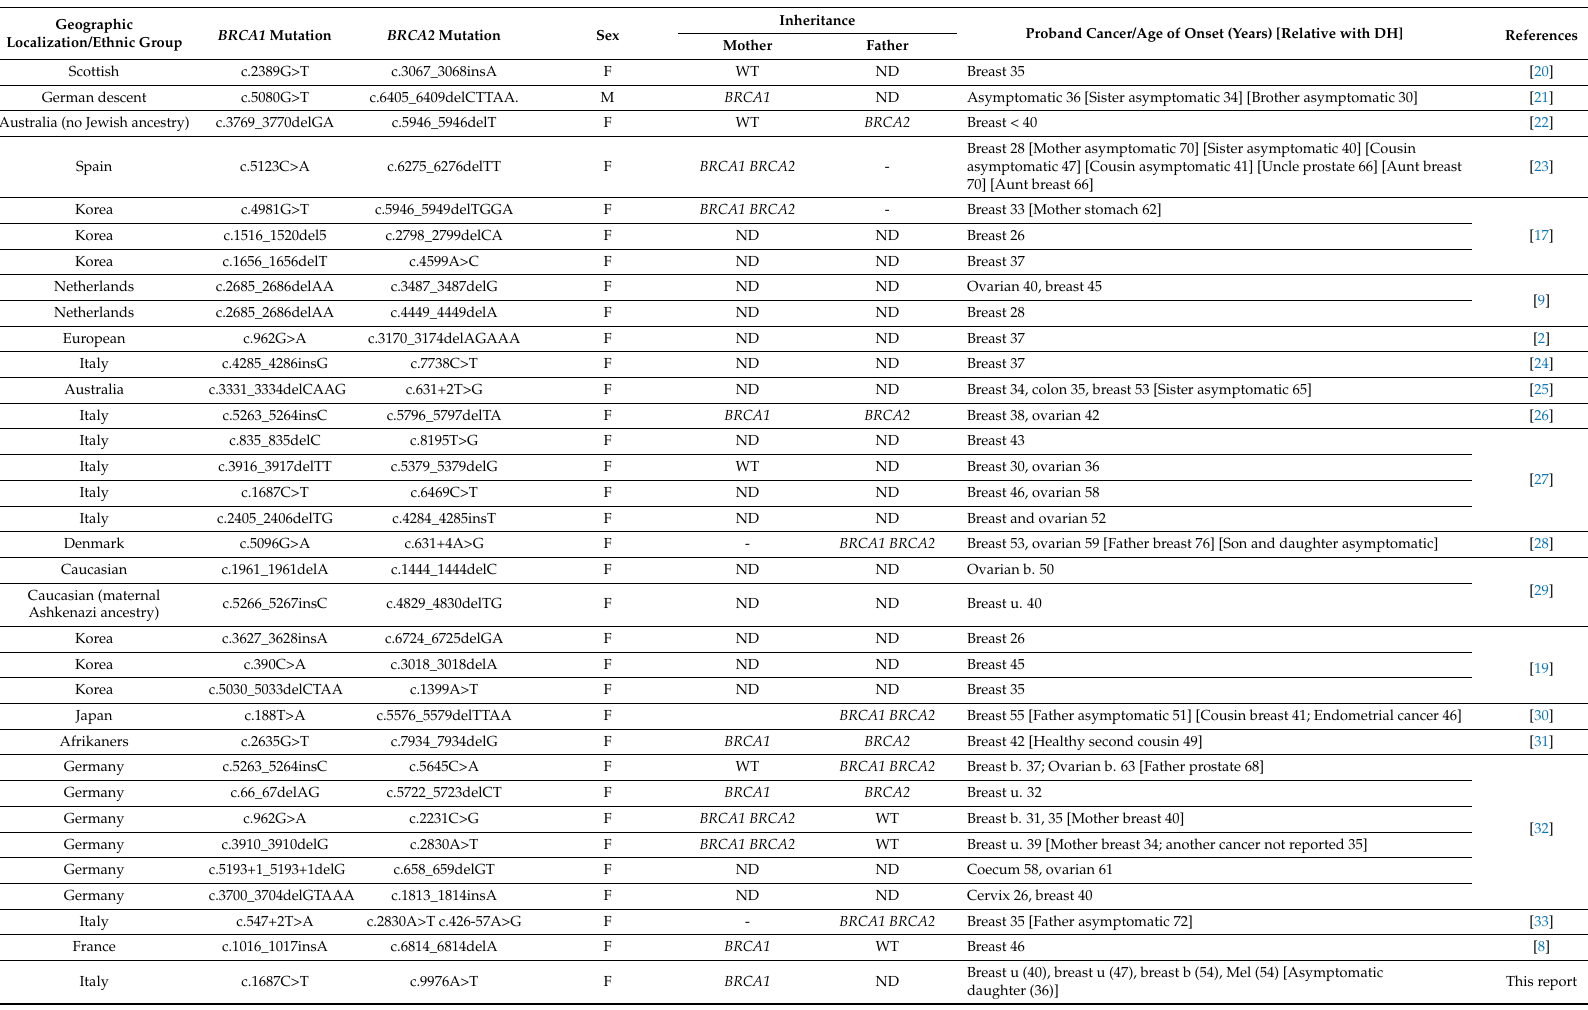
Table 1. Data of females with BRCA1 and BRCA2 double heterozygosity published in the literature. WT: Wild Type; ND: Not Determined; DH: double heterozygosity; breast u.: breast unilateral; breast b.: breast bilateral; ovarian b.: ovarian bilateral; Mel: